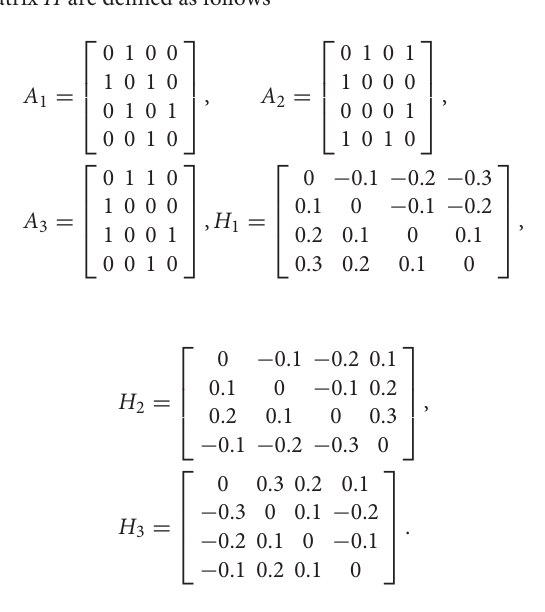
matrix H are defined as follows